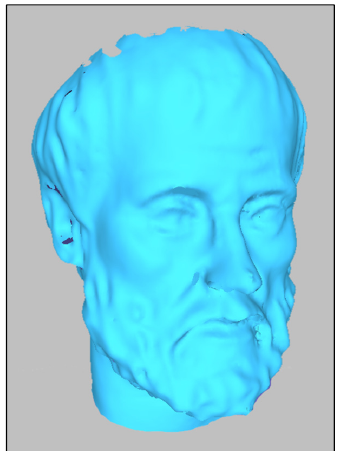
Figure 1. Aristotle sculpture at ITU Geomatics Engineering Department Metrology Laboratory.